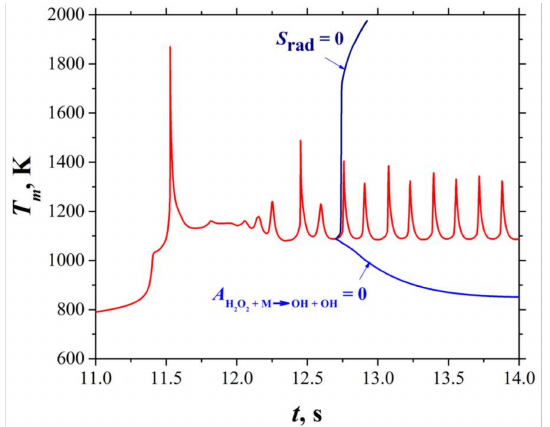
Figure 16. Calculated time histories of the maximum gas temperature, T m , at self-ignition of the n-dodecane droplet with D 0 = 4.0 mm in air at T g 0 = 700 K and P = 1 bar. Curves designated as A H = 0 and S rad = 0 show the flame temperature evolution in two mathematical 2 O 2 + M → OH + OH